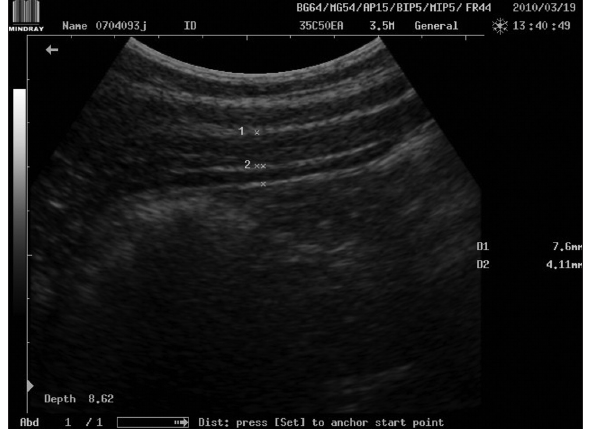
Figure 3: Resting Image of the Left Lateral Abdominal Wall The first measurement was taken at the end of respiration. The measurement at rest of OI (D1) was 7.6mm and for TrA (D2) was 4.11mm.